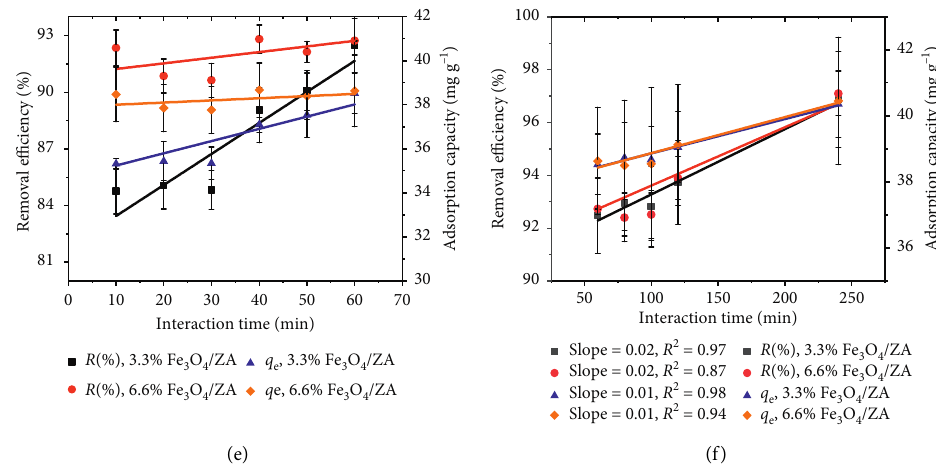
Figure 7: UV-VIS absorbance spectra of supernatants collected from batch adsorption experiments. (a) The absorbance spectra of the MB solution treated by Fe 3 O 4 /ZA nanocomposite with different Fe 3 O 4 NP loadings; (b, c) absorbance spectra of 3.3% Fe 3 O 4 /ZA and 6.6% Fe 3 O 4 /ZA samples at different interaction (adsorption) times; (d) removal efficiency ( R , %) and adsorption capacity ( q e , mg · g − 1 ) of 3.3% Fe 3 O 4 /ZA and 6.6% Fe 3 O 4 /ZA samples, respectively; linear fitting results of removal efficiency and adsorption capacity in adsorption ranges of 0–60minutes (e) and 60–240 minutes (f) in (d); the experiments data are presented as solid dots with error bars, while solid lines are linear fitting results of experiments data in Figures 7d, 7e, and 7f. Table 2: Effect of Fe 3 O 4 loading to the adsorption capacity and removal efficiency of the as-synthesized Fe 3 O 4 /ZA nanocomposite.